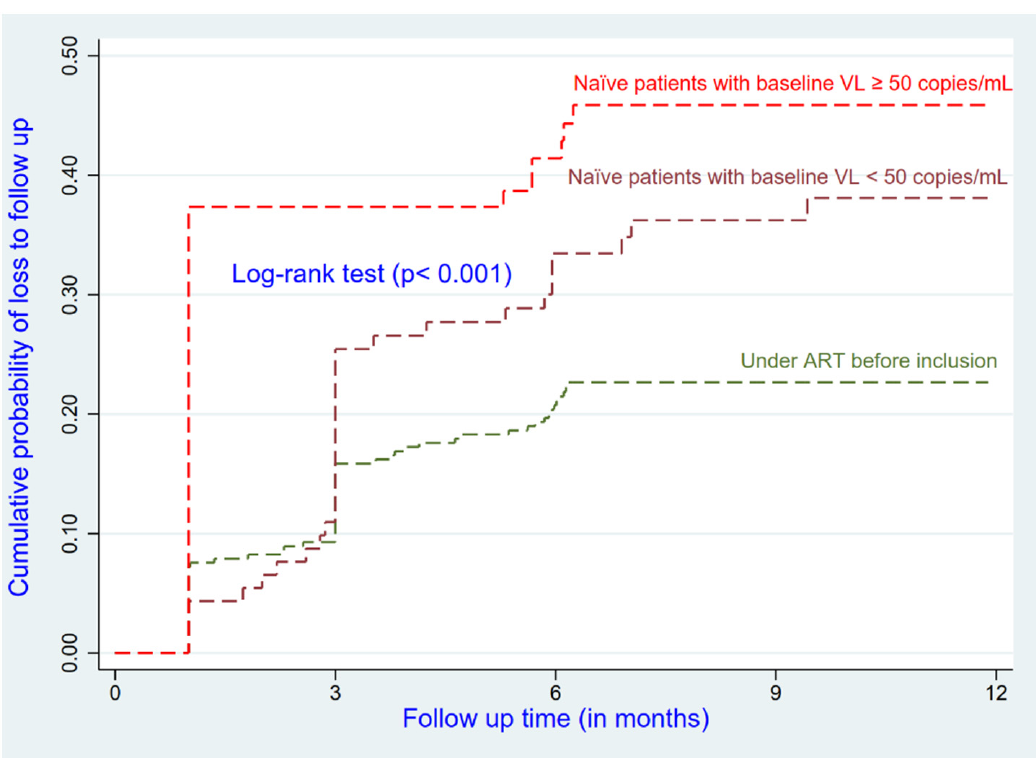
Figure 2. Cumulative incidence of LTFU by status of treatment at baseline.